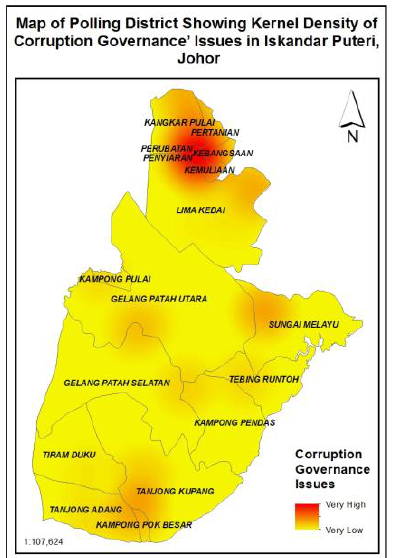
Figure 17. Result of the hot spot maps using KDA for corruption governance issues